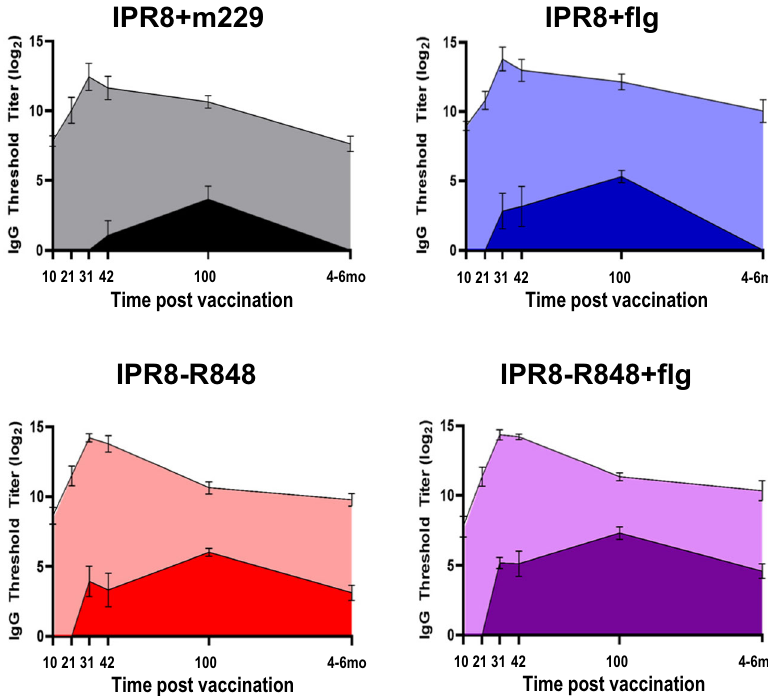
Fig. 2 Kinetics of the IgG response to whole virus and HA stem. Average IgG titers over time to the HA stem (dark shading) and PR8 virion (light shading) for animals vaccinated with IPR8 + m229, IPR8 + fl g, IPR8-R848, and IPR8-R848 + fl g as in Fig. 1. Titers to PR8 have been previously reported for this cohort of animals (1,